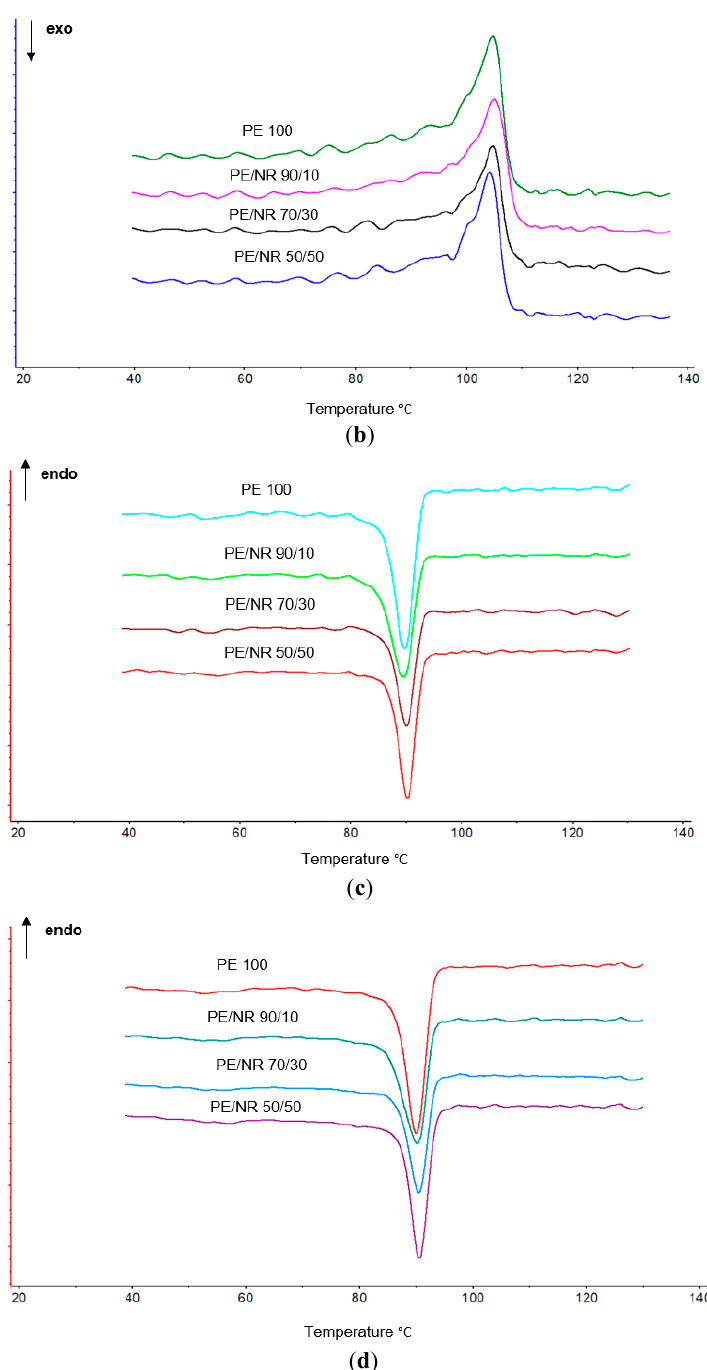
Figure 6. Melting peaks of initial samples: first heating ( a ), second heating ( b ). Cooling peaks of initial samples: first heating ( c ), second heating ( d ).